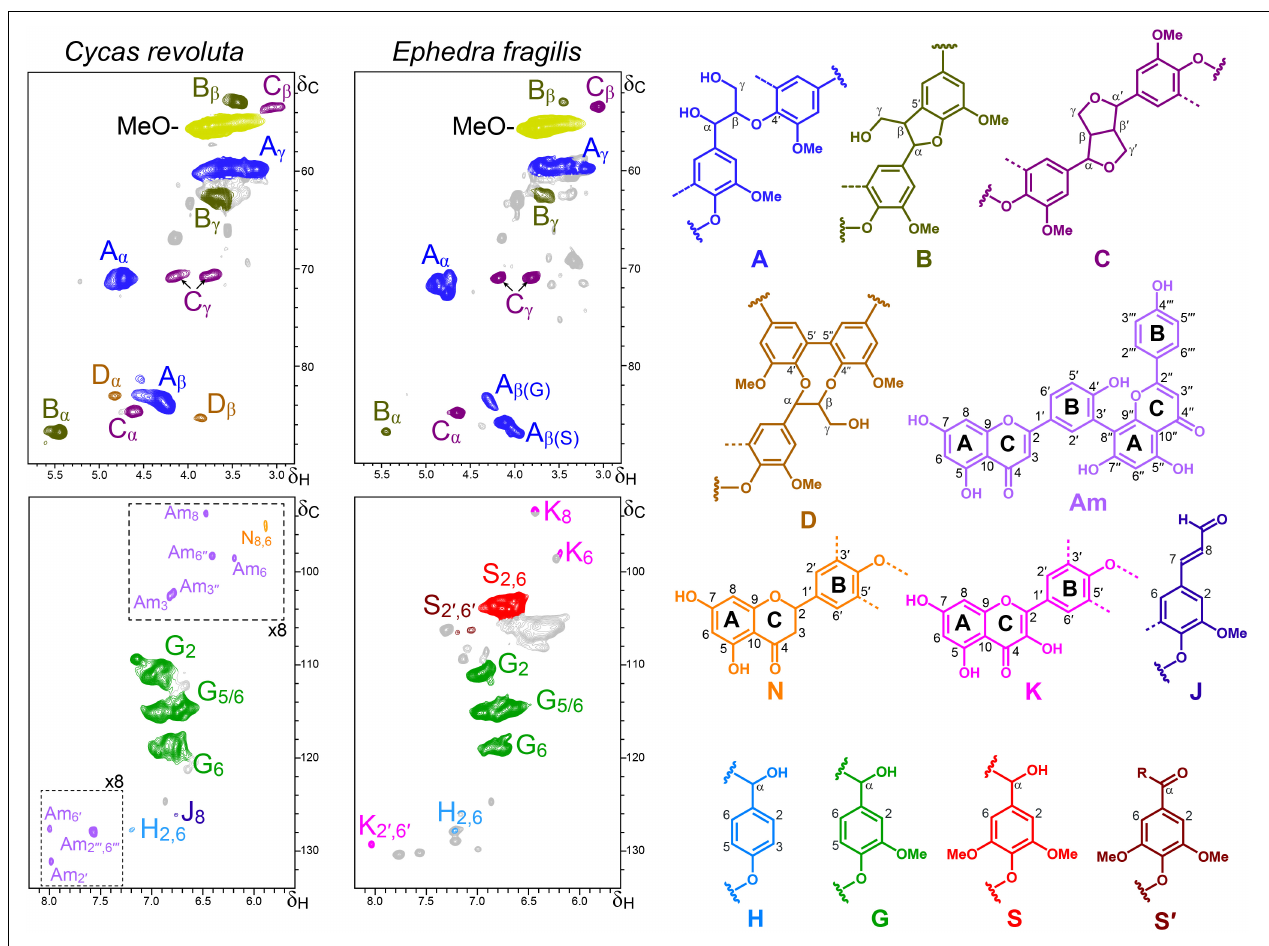
FIGURE 6 | Aliphatic-oxygenated ( δ C / δ H 50–90/2.8–5.8) and aromatic ( δ C / δ H 92–134/5.5–8.2) regions of the HSQC spectra of the C. revoluta and E. fragilis lignin-like preparations. The main structures identified – corresponding to β – O –4 (cid:48) ether (A), β –5 (cid:48) (B), β – β (cid:48) (C) and 5–5 (cid:48) (D) side chains, p -coumaryl (H), guaiacyl (G) and syringyl (S and S (cid:48) ) units, coniferaldehyde end-groups (J), and naringenin (N), kaempferol (K) and amentoflavone (Am) moieties – are depicted on the right. The dash-line boxes in the C. revoluta spectrum are scaled-up ( × 8